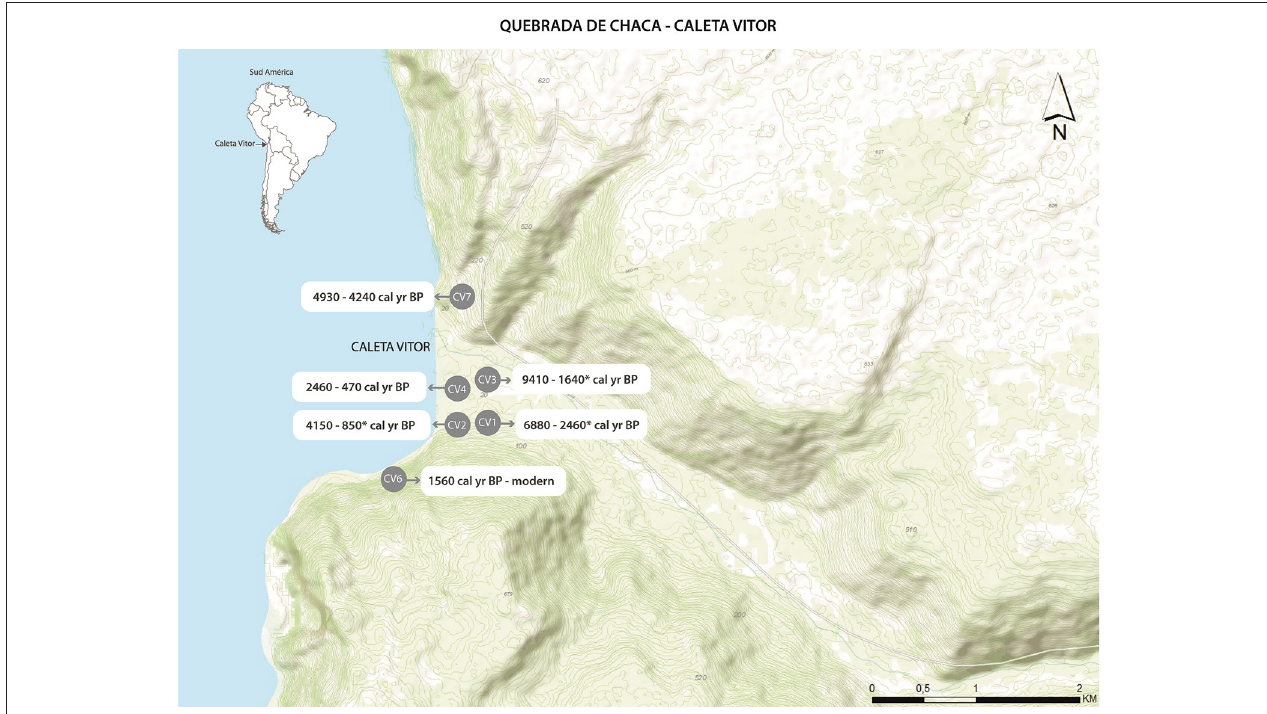
FIGURE 2 | Map of the Caleta Vitor archeological area, showing the major shell midden deposits (in gray and numbered CV1, CV2, etc.) along with associated radiocarbon date age ranges. All ages in calibrated 14 C years BP.